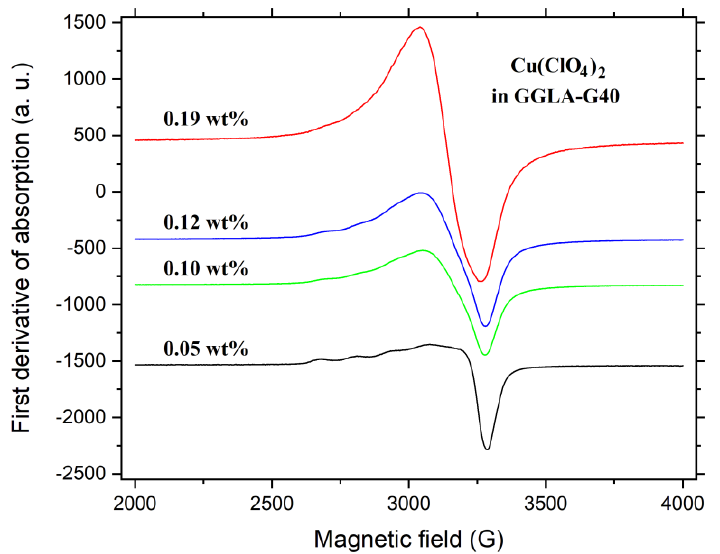
Figure 7. X-band CW-EPR spectra, measured at ≈ 300 K, of GGLA-G40 samples at different Cu(ClO 4 ) 2 concentrations. All spectra were measured at the same experimental conditions and normalized to the sample mass. The microwave frequency was 9.43 GHz.